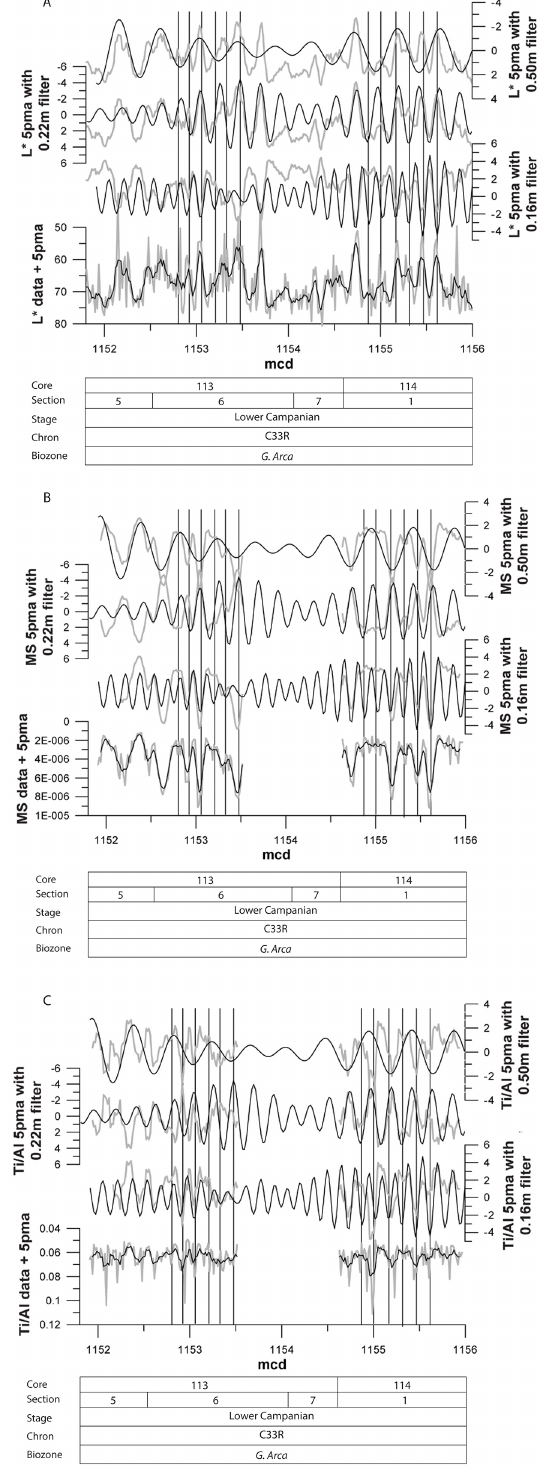
Figure 7. L ∗ (A) , MS (B) and Ti / Al (C) with 0.50m (0.50m ± 0.09m), 0.22m (0.22m ± 0.014m) and 0.16m (0.16m ± 0.026m) filters of L ∗ . The panel below shows the stratigraphic position of the studied interval and which core sections were